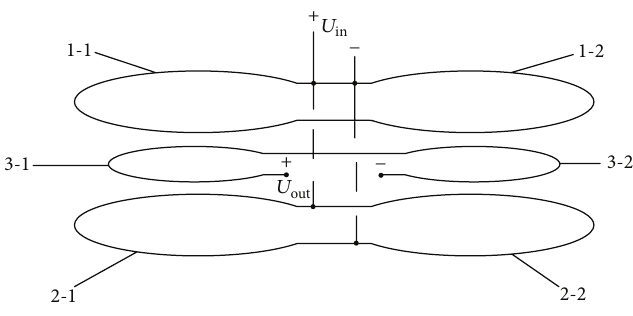
Figure 3: The structure diagram of DTC antenna.